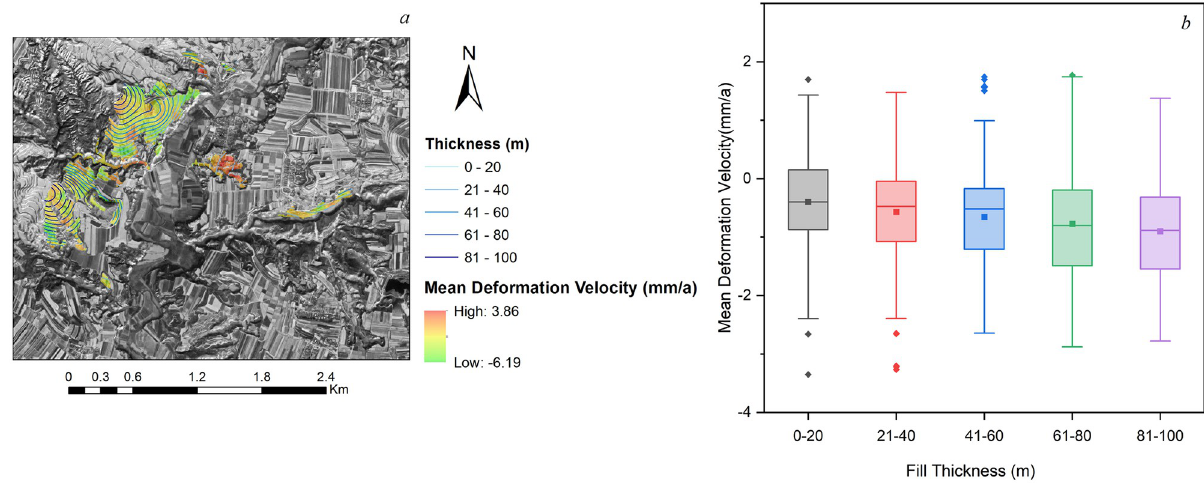
Fig 12. Subsidence rate and fill thickness in gully control and land